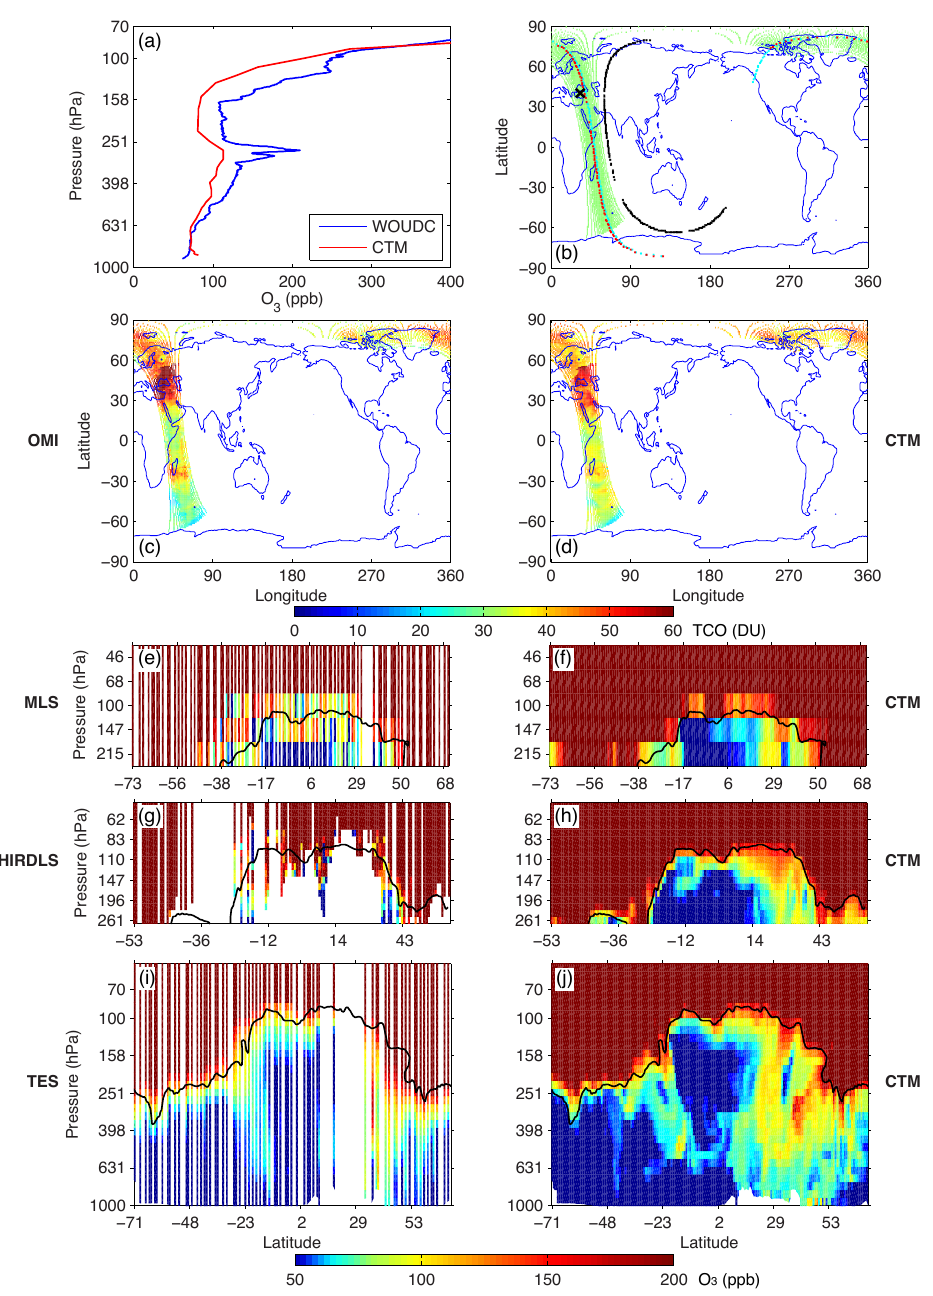
Fig. A4. Same as Fig. A2 for 3 August 2005. The sonde was measured at